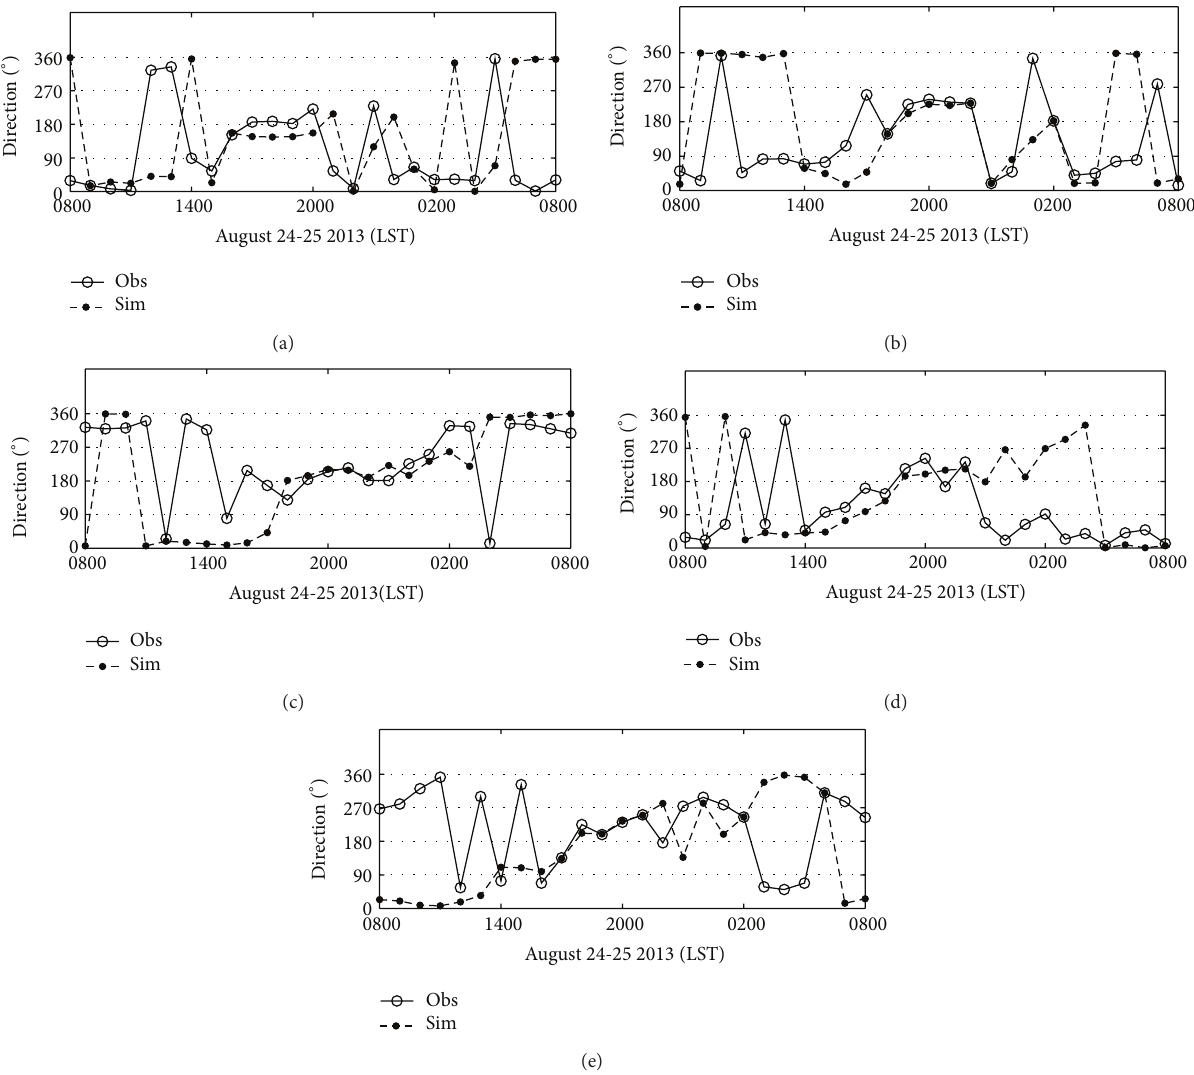
Figure 4: Time series of observed and simulated 10m wind direction ( ∘ ). Please refer to Figure 2 for the descriptions of the figures.